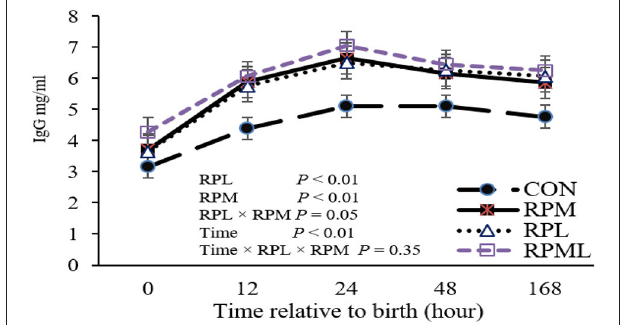
FIGURE 1 | Effect of rumen-protected lysine and methionine supplementation to close-up cows on overall immunoglobulin G (IgG) concentrations of their heifer calves. Calves were assigned to treatments based on the pre-calving treatment of their dam, fed unsupplemented AA diet (CON), or receiving supplemental with ruminally-protected lysine (RPL) or methionine (RPM) or the two in combination (RPML). Values are means. Standard errors are represented by vertical bars. FIGURE 2 | Scatterplot of serum total protein concentrations by colostrum